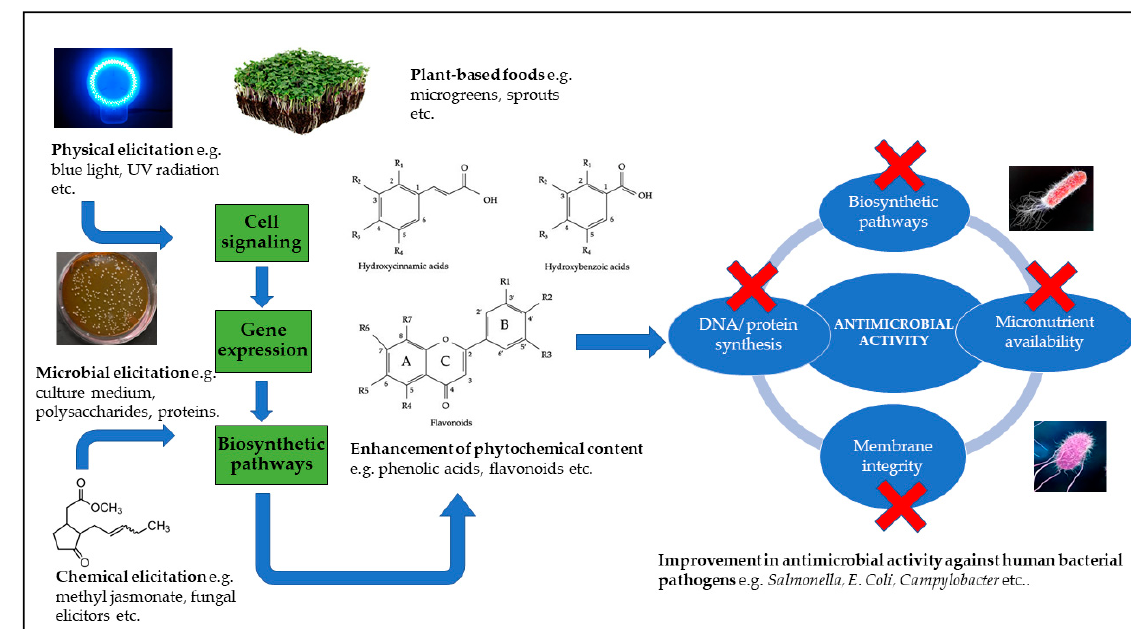
Figure 2. Elicitation strategies to improve phenolic metabolites and associated antimicrobial activity against human bacterial pathogens in plant models.